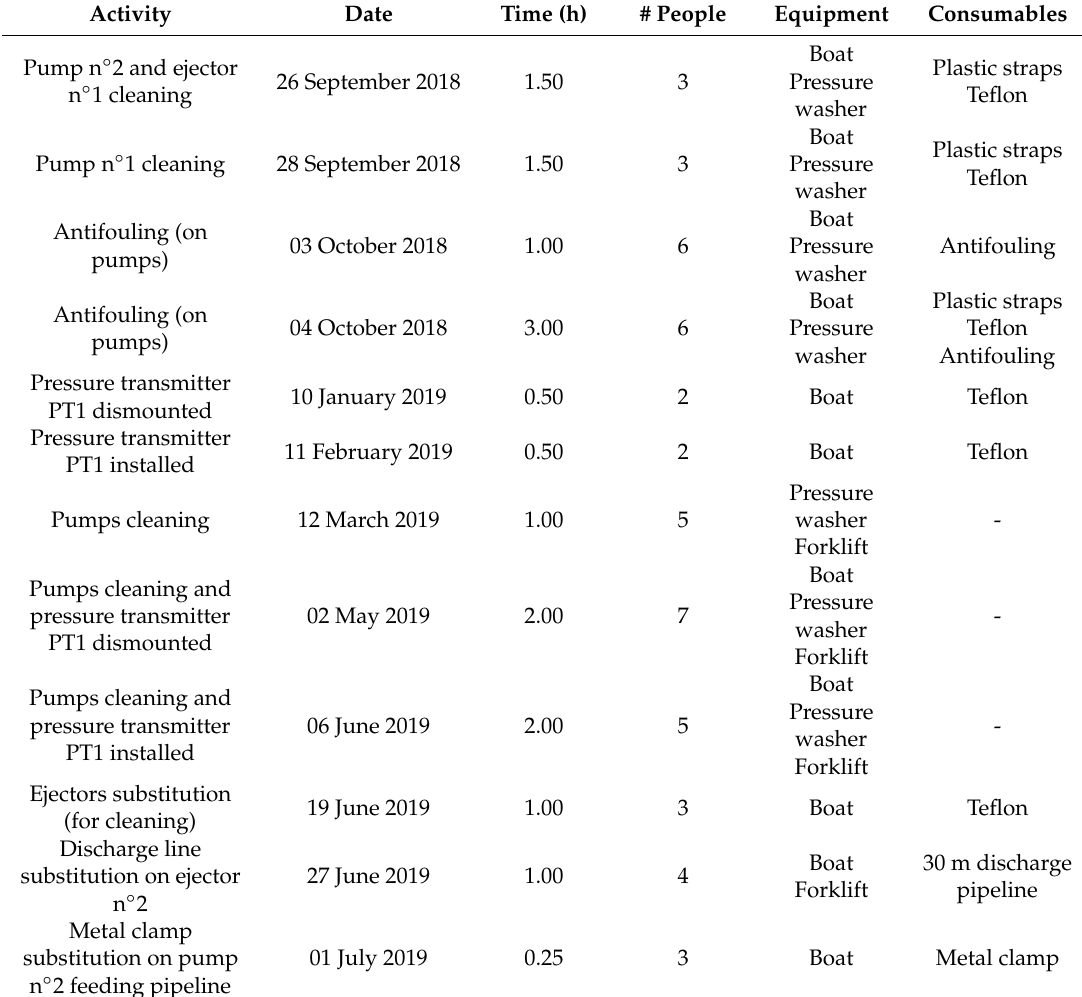
Table 7. List of maintenance activities carried out in the period August 2018–August